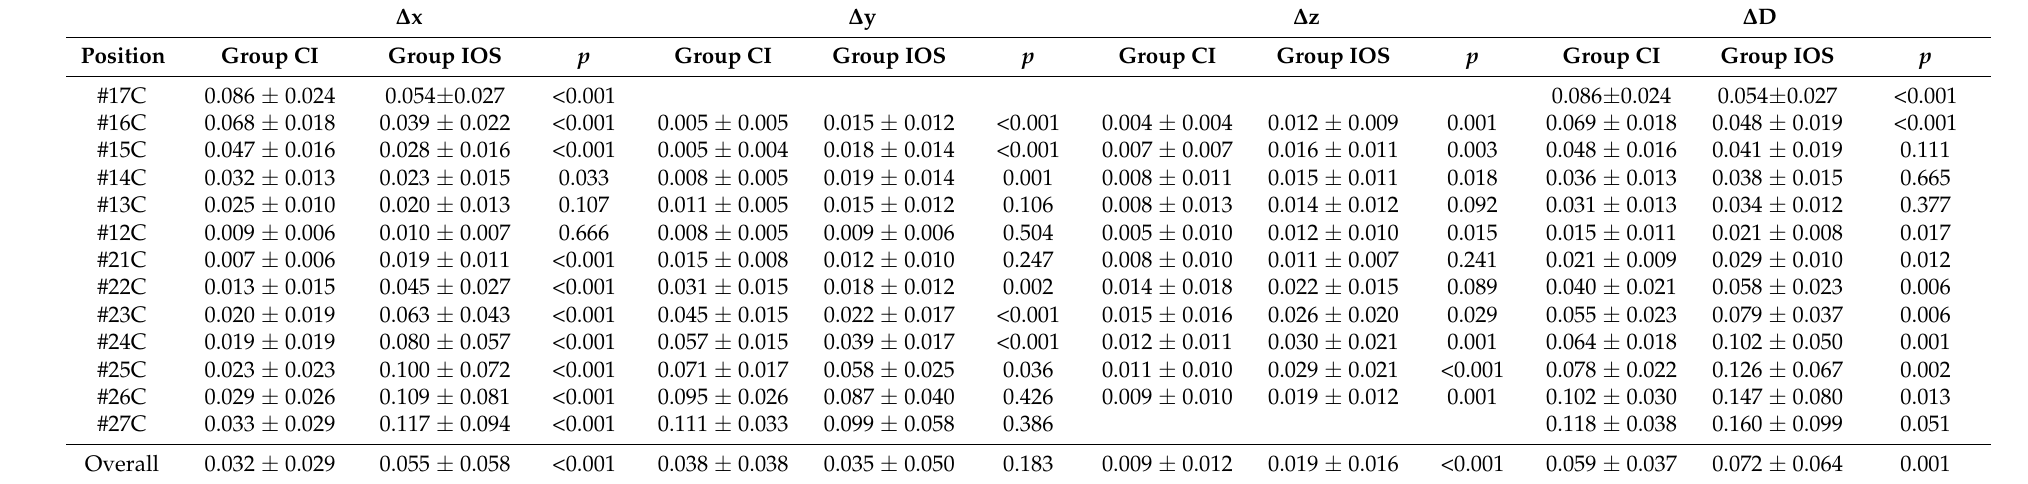
Table 2. Absolute trueness values and standard deviation (SD) for x, y, z coordinates and 3-dimensional linear distortion